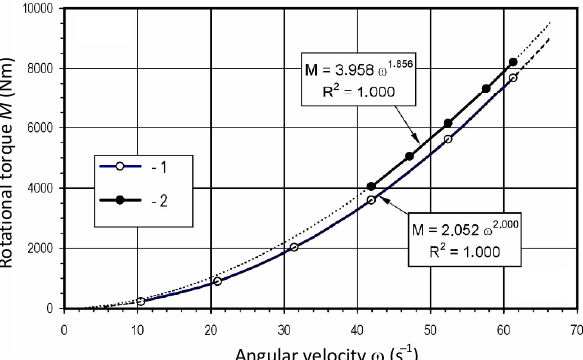
Figure 7. Waveforms of rotational torque across the pump shaft as a function of angular velocity for: 1 − H g =0 m; and 2 − H g =4 m.